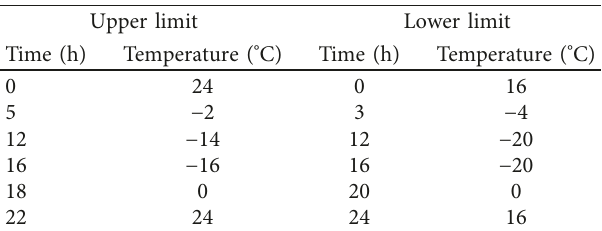
Figure 5: Temperature and time cycles for the freeze-thaw test. Table 16: Limit values of temperature and time cycles for the freeze-thaw test